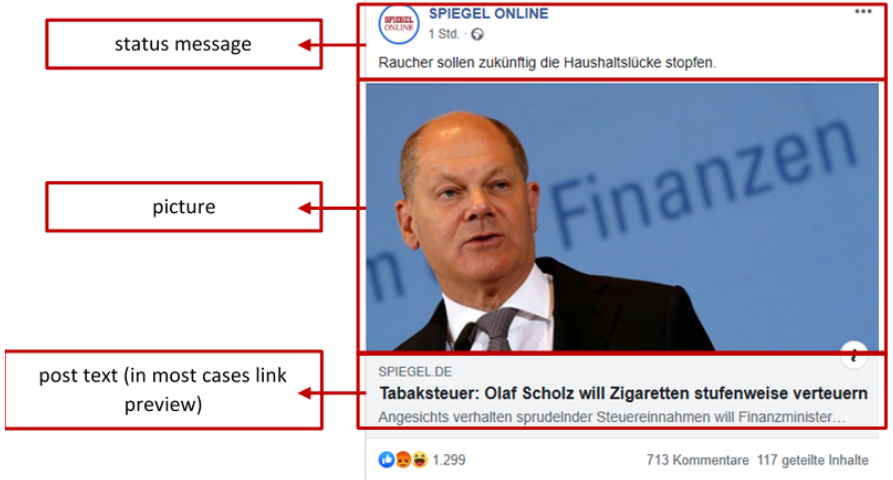
Figure 2. Structure of Facebook posts: Units of analysis. Note: See Welbers and Opgenhaffen (2019, p. 50). analysis of Belgian and Dutch newspapers, but they re- stricted their study to a single soft news aspect, the use of subjective